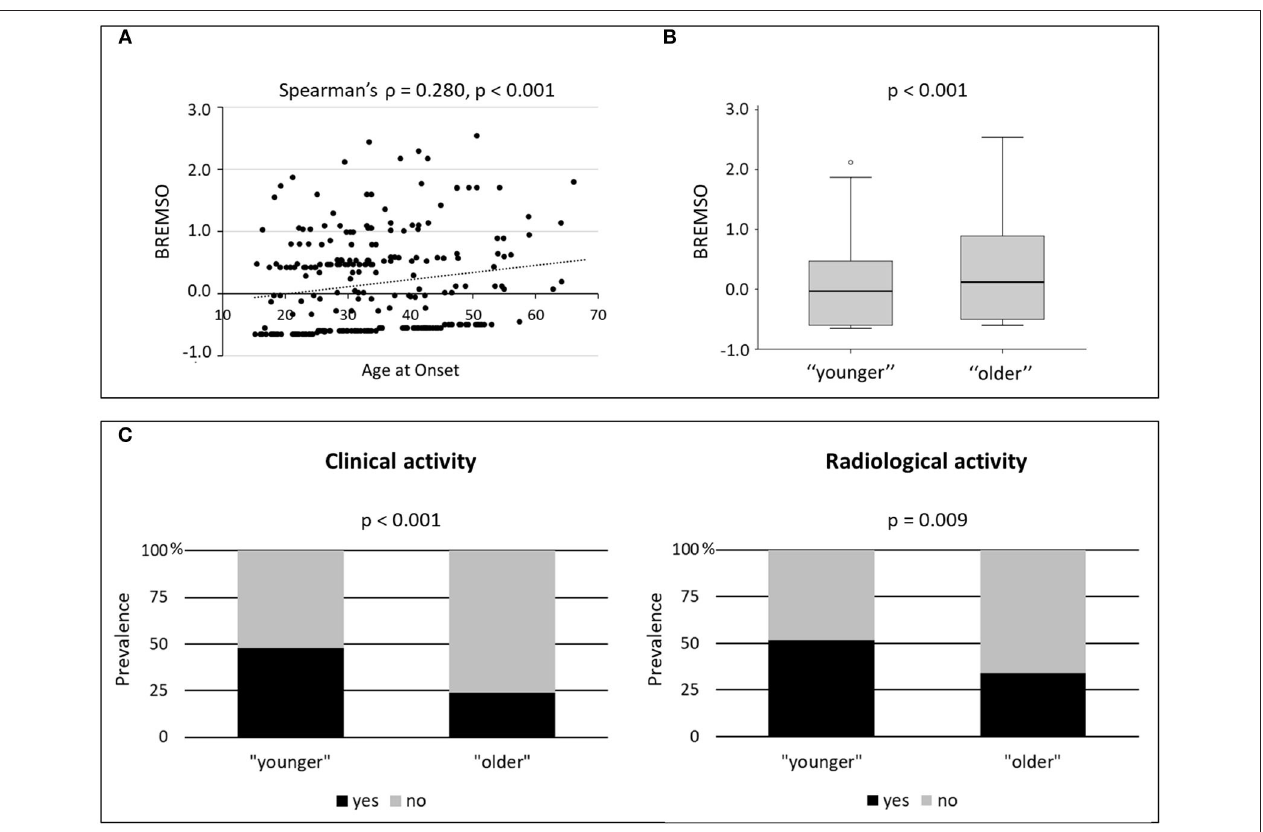
FIGURE 1 | Age and clinical characteristics. (A) Correlation between age at onset and BREMSO; Spearman’s ρ and p -value are shown. (B) BREMSO in “younger” and “older” patients with multiple sclerosis (MS); the B–H adjusted p -value of the Mann–Whitney U test is shown. (C) Prevalence of clinical and radiological disease activity in “younger” and “older” patients with MS; the B–H adjusted p -values of the χ 2 test are shown. B–H, Benjamini–Hochberg; BREMSO, Bayesian risk estimate for MS at the onset.